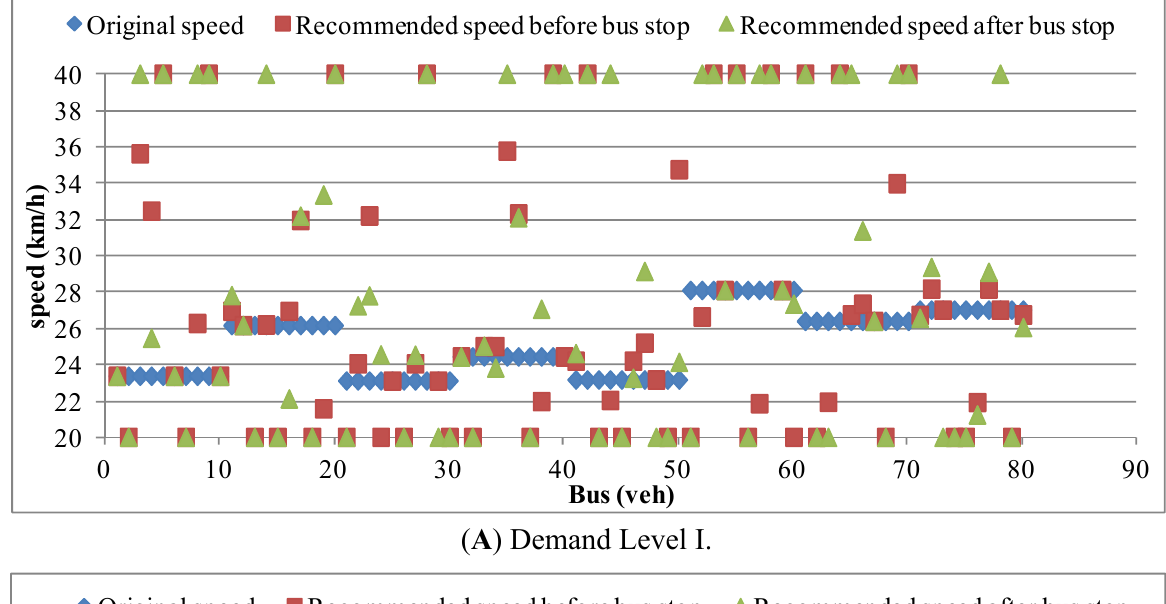
Figure 7. Comparison of recommended bus